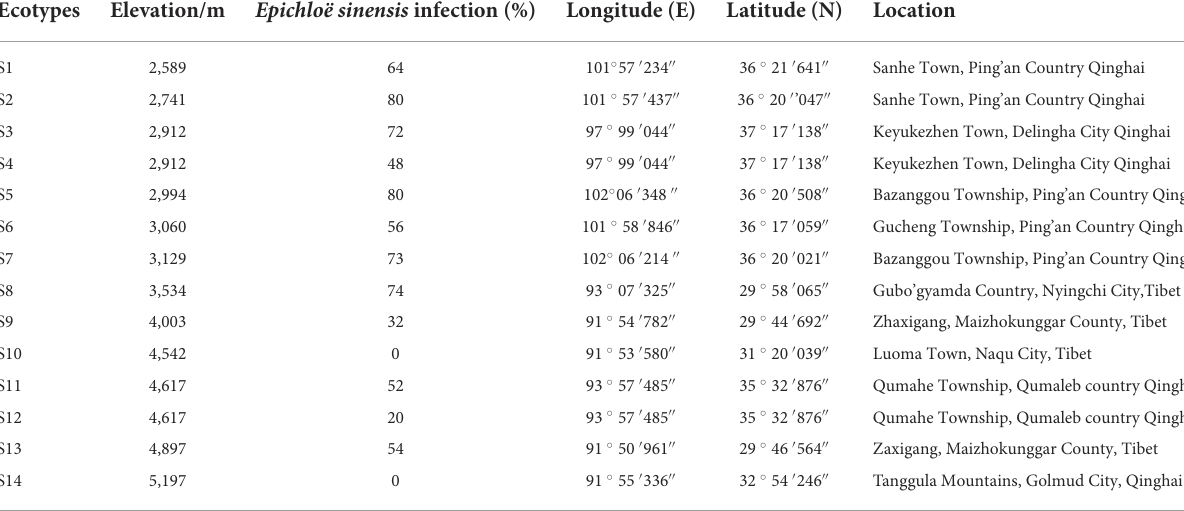
TABLE 1 Festuca sinensis seeds collected from different locations in Qinghai-Tibet